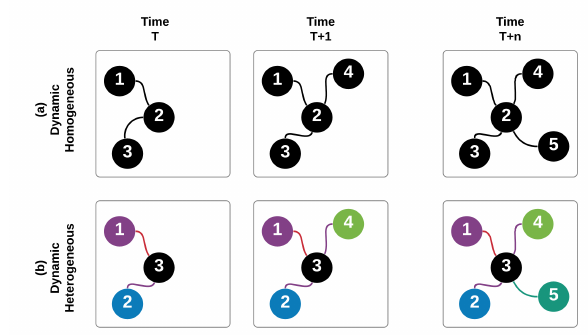
Figure 8. Example of Dynamic Networks